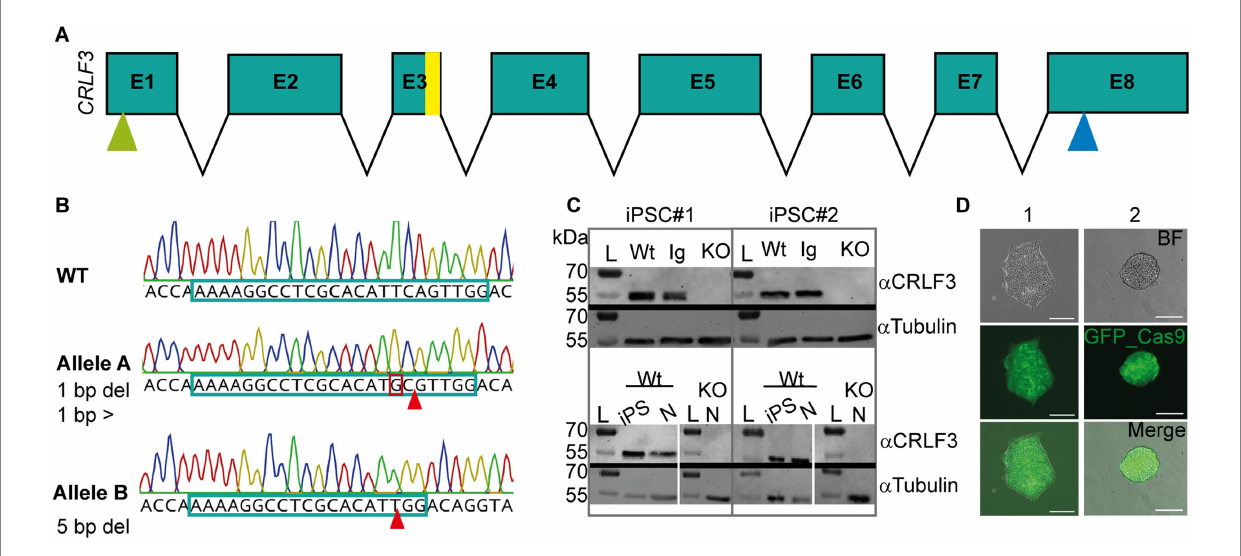
FIGURE 1 Characterization of CRISPR-induced CRLF3 mutation in human iPSC lines. (A) Schematic overview of the CRLF3 gene. Exons are represented as boxes, with sizes corresponding to exon length. Introns are represented as arrows and do not depict intron length. Yellow bar in exon 3 (E3) shows mutation site. Green and blue arrows mark start and stop codon of the coding sequence, respectively. (B) Chromatograms illustrating mutations in alleles A and B of iPSC#1 line. Top : WT sequence, with gDNA scaffold marked by framed portion of the nucleotide sequence. Middle : Allele A of the mutated line, which is characterized by one deleted base pair (marked with arrow) and a base pair exchange (marked by red box). Bottom : Allele B of the same iPSC line lacking a row of 5 deleted base pairs. Both mutations induce frameshifts that generate premature stop codons. (C) Western blot analysis of Ig-Ctrl and mutated iPSC lines and differentiated neurons. L, Ladder. Top : Protein lysates of iPSC#1 and #2 probed for CRLF3 and α Tubulin. WT and Ig-Ctrl lysates show bands for CRLF3 protein, while the mutated lines (marked with KO) do not. α Tubulin probed as loading control appears for all lines. Bottom : Western blot analysis of differentiated neurons originating from WT or CRLF3 mutated cells of both lines. While WT lysates show bands for CRLF3, no protein was detected in KO cells. α Tubulin bands are present. (D) Transfected iPSC colonies express EGFP as reporter gene. Both lines show homogeneous eGFP expression within iPSC colonies consisting of more than 100 cells. Scale bar: 50 μ